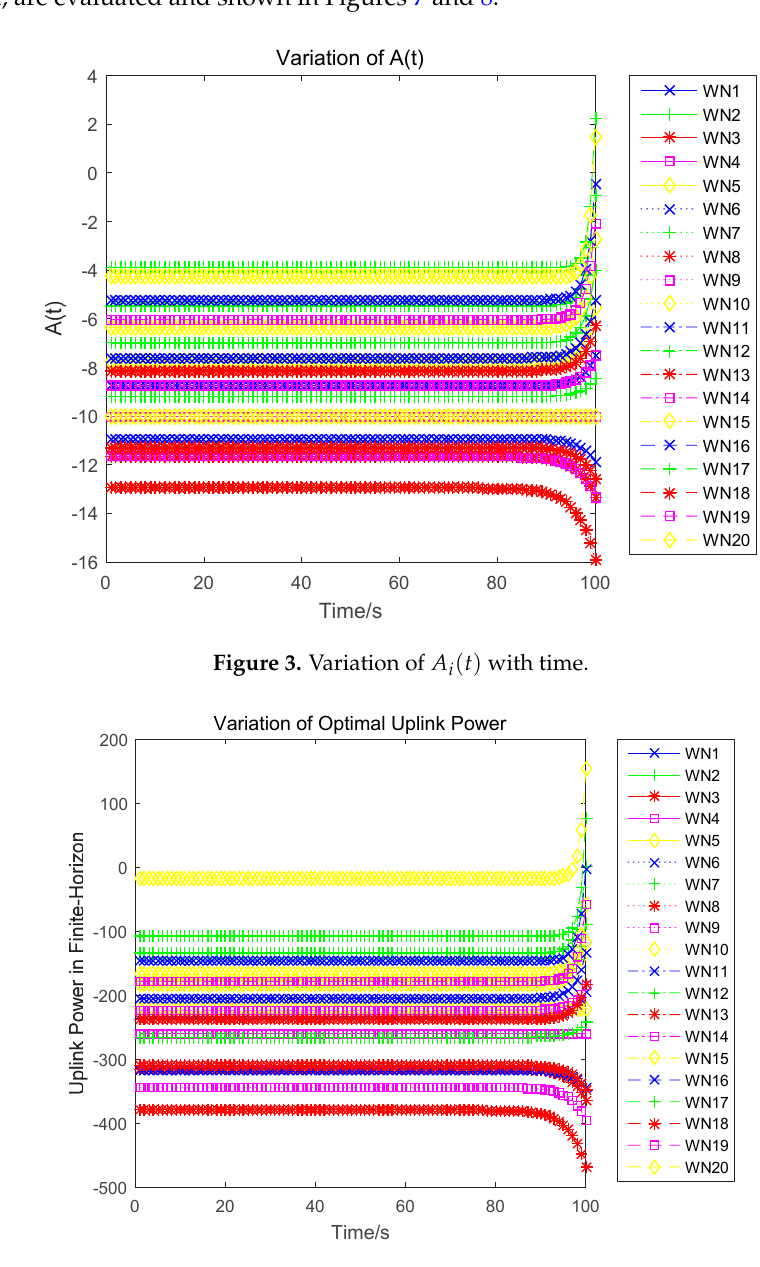
Figure 4. Variation of the optimal uplink power in finite-horizon.